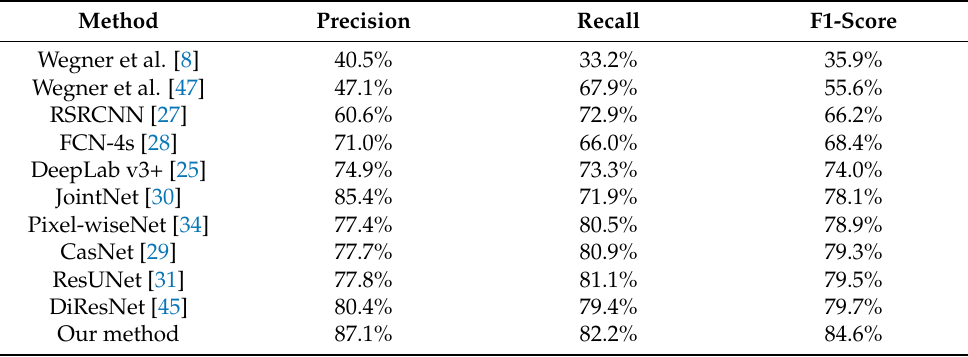
Table 2. Results of different methods for the Massachusetts roads dataset.